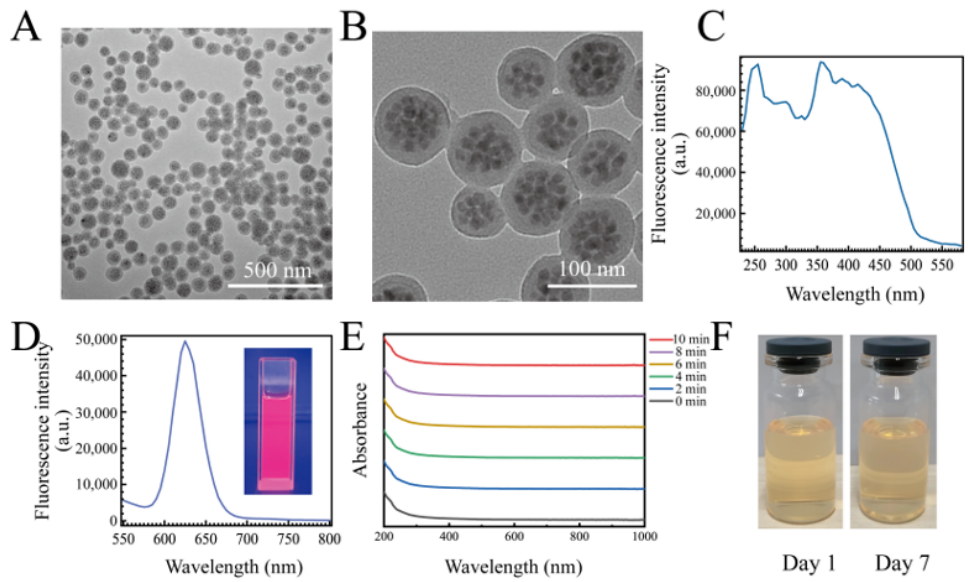
Figure 1. The characterization of the QDFM. ( A , B ) TEM images of the QDFM. ( C , D ) The excitation and emission spectrum of the QDFM. ( E ) The UV–vis absorbance of QDFM in different time nodes during the UV light exposure. ( F ) The picture of the QDFM suspension on day 1 and day 7.